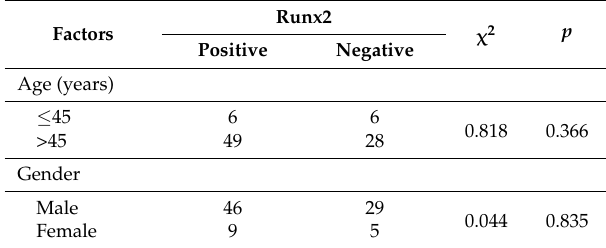
Table 1. Correlation between Runx2 expression and clinicopathologic parameters, and